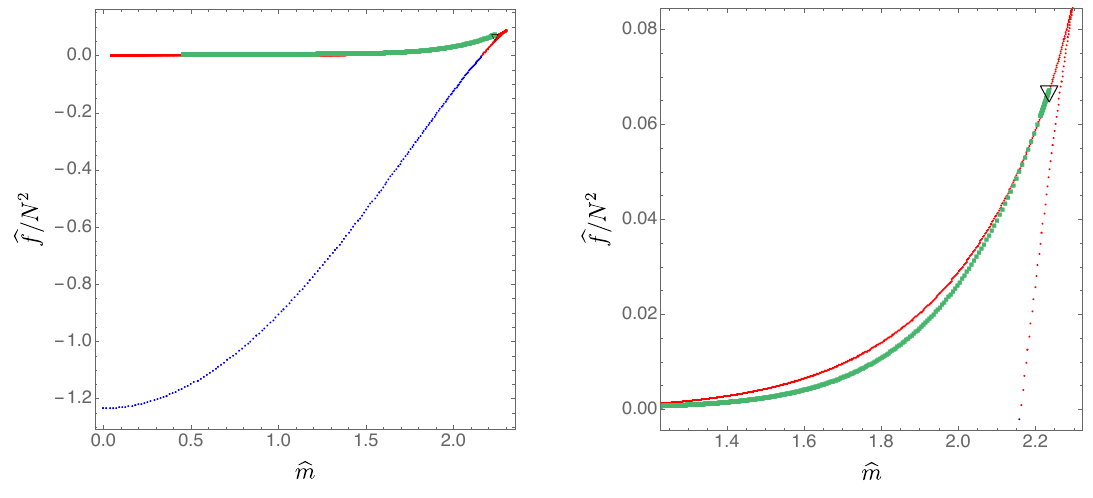
Figure 6 . Canonical-ensemble phase diagram b f=N 2 vs densate ( (cid:27) 6 = 0) family of solutions. The blue and red disks describe the solutions with (cid:27) = 0 already presented in (cid:12)gure 4. But this time we also display, using green squares, the branch of solutions with (cid:27) 6 = 0. The black inverted triangle O corresponds to The right panel zooms close to this second-order transition point between the two phases. The nonzero-gaugino branch of solutions never dominates the canonical ensemble.